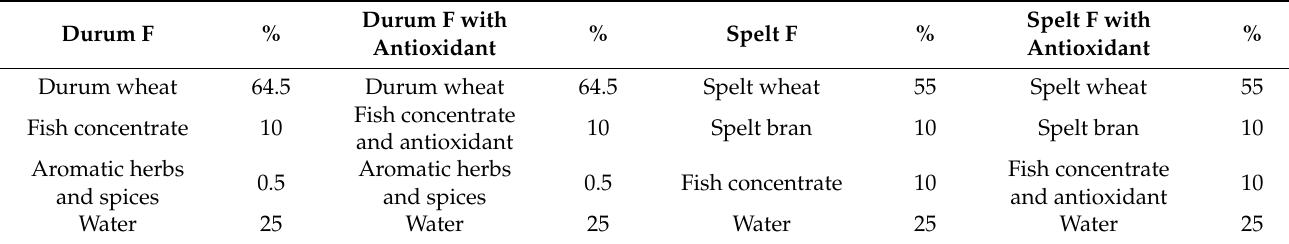
Table 1. Composition of